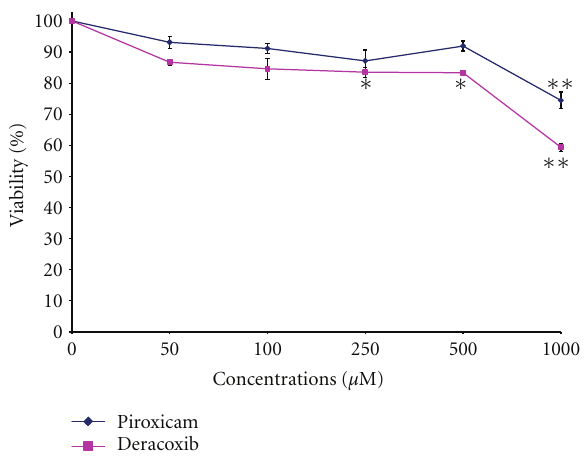
Figure 1: The e ff ects of piroxicam and deracoxib on the prolifer- ation of the canine mammary carcinoma cell line CMT-U27. Data are expressed as the percentage of inhibition compared with control in which cell survival was assumed as 100%. ∗ P < 0 . 05, ∗∗ P < 0 . 01 ( n = 3).